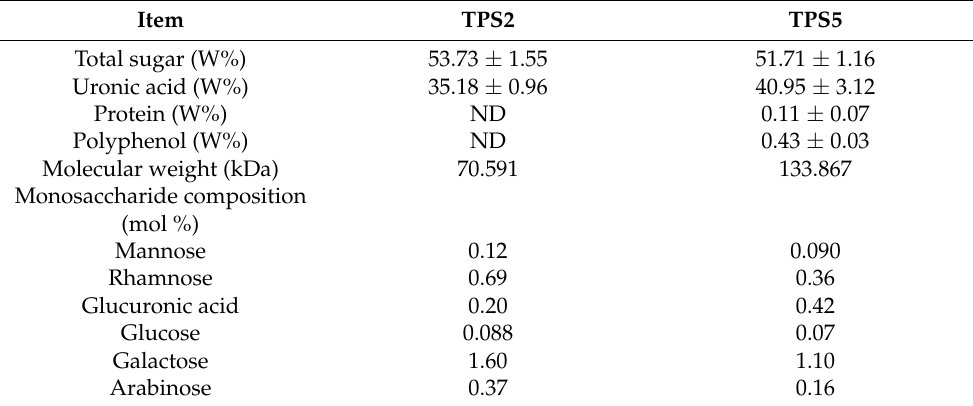
Table 1. Structural characterization of TPS2 and